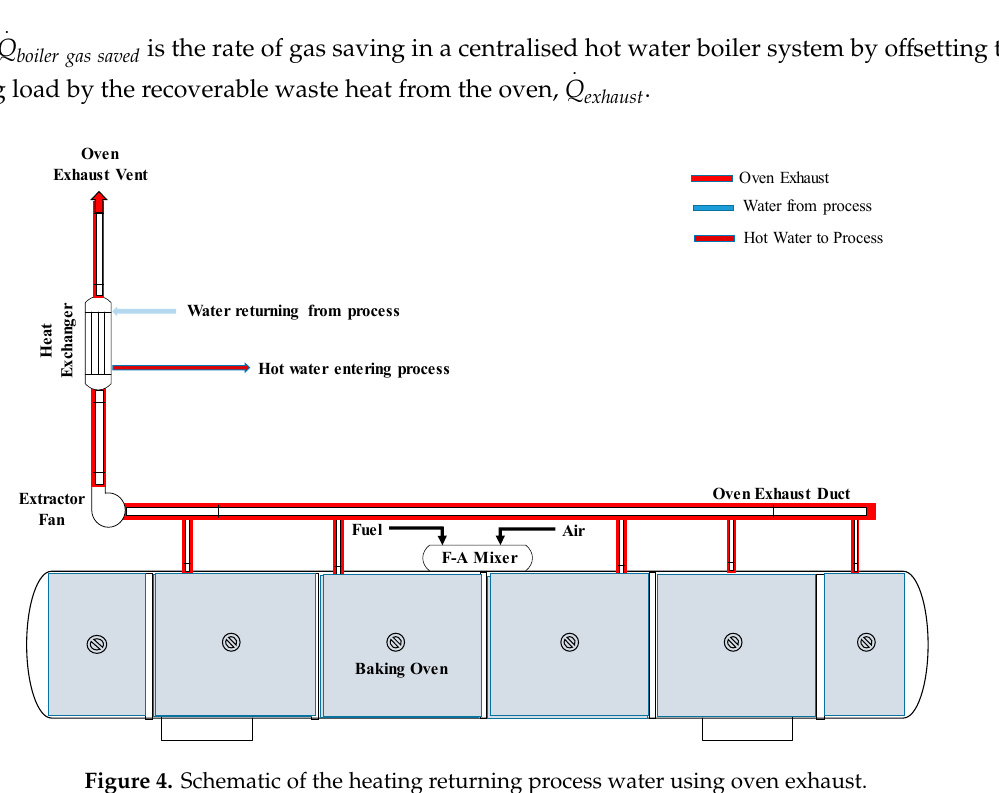
Figure 4. Schematic of the heating returning process water using oven exhaust.